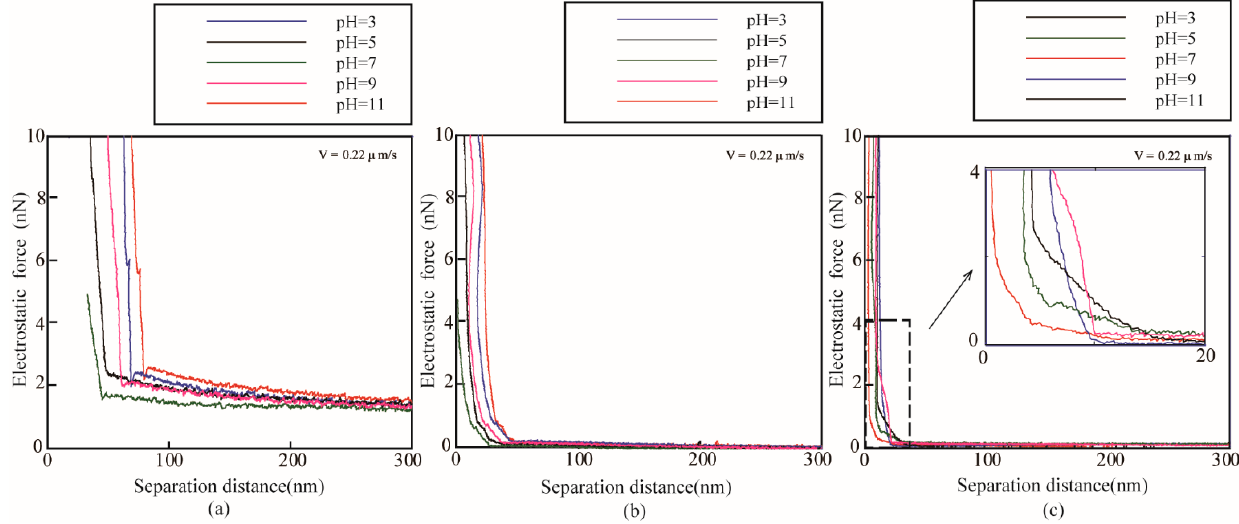
Figure 4. Measured electrostatic force of ( a ) superoleophilic, ( b ) oleophobic, and ( c ) superoleophobic surfaces immersed in ethylene glycol with different pH value obtained at a sphere velocity of 0.22 μ m/s.